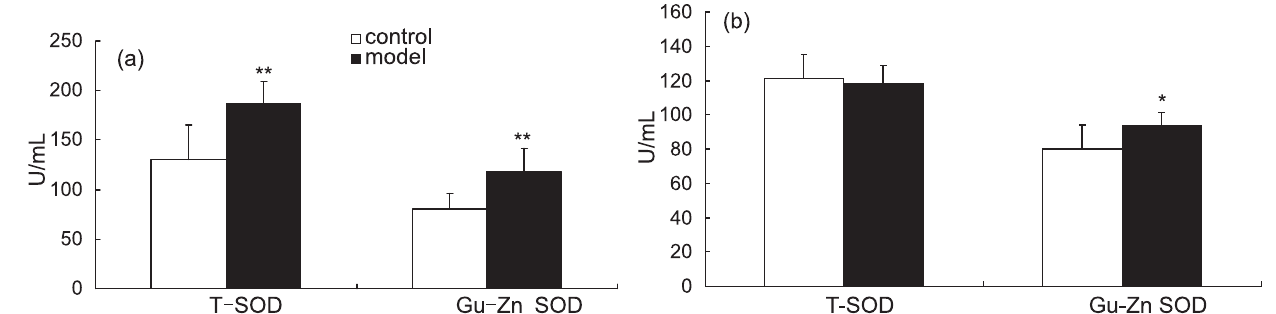
FIGURE 2 - Effects of hyperuricemia on T-SOD and Gu,Zn-SOD activity in serum in different time. Data are mean ±SD, n =8. (a): in 2 nd week and (b): in 4 th week. * P<0.05, ** P<0.01 compared with control group